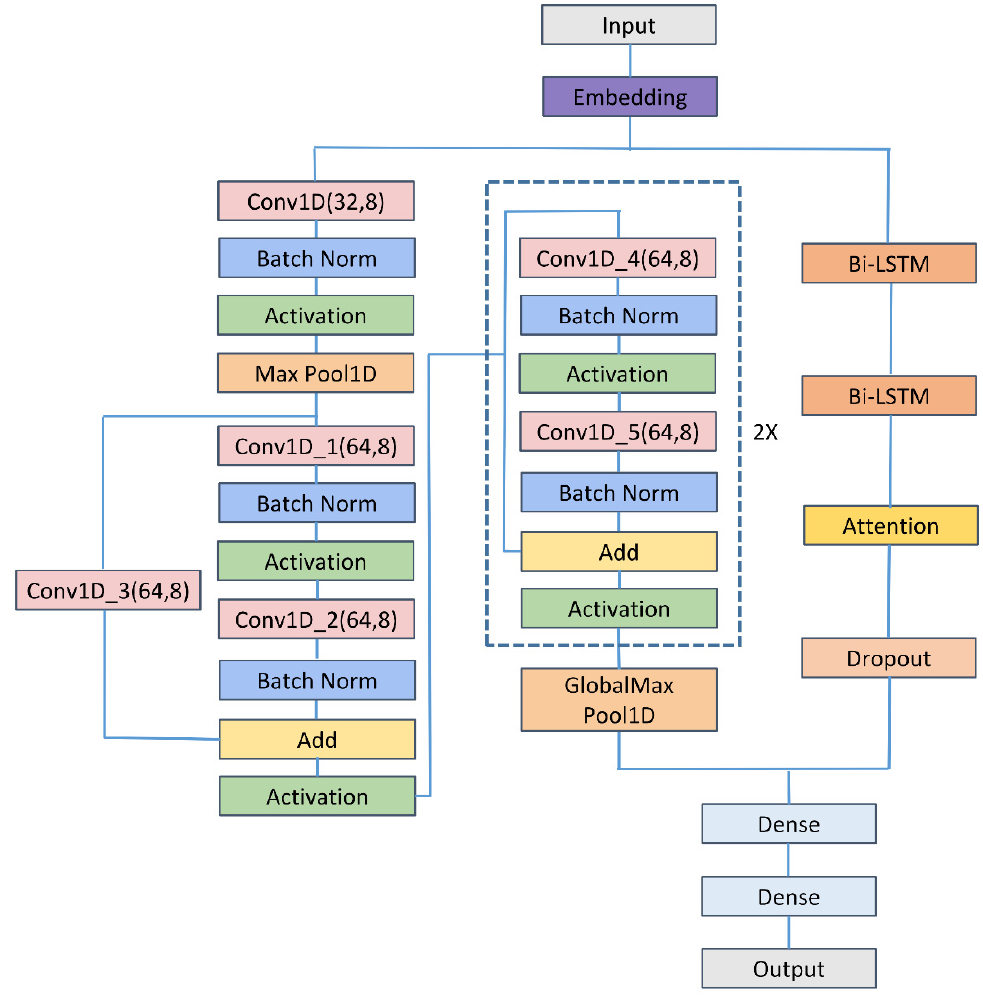
Figure 1. The architecture of the Enhancer-LSTMAtt. Conv1D, Batch Norm, Attention, Activation, Dense, and Max Pool 1D denote the 1D CNN layer, the batch normalization layer, the feed-forward attention layer, activation function, the fully-connected layer, and the max pooing layer respec- tively. Table 1. The shapes of outputs and the numbers of parameters in the Enhancer-LSTMAtt.